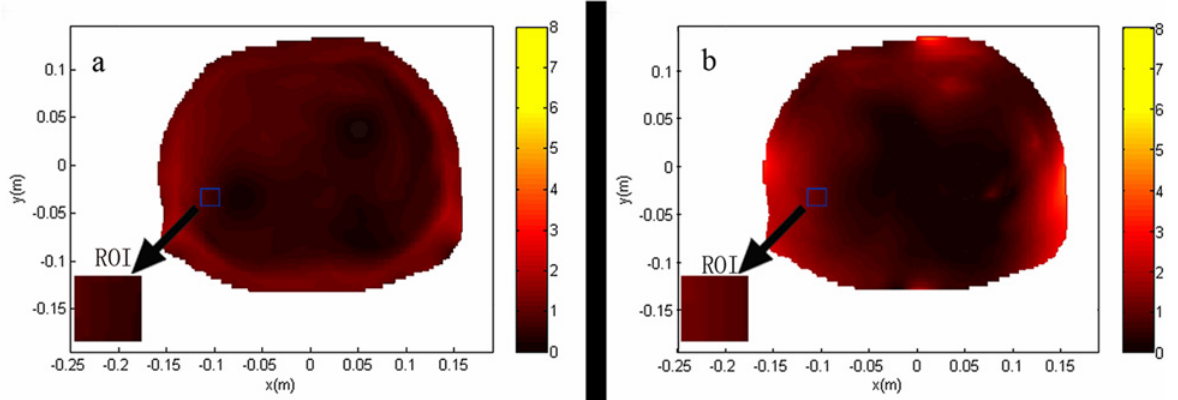
Fig 7. Theoretical B 1 field distribution through the transverse planes centered at the ROI used for the calculation of SNR of different coils. The value of SNR was obtained when the mean B 1 value within the ROI was 1.957 μ T. The SNR of body coil was normalized to 1 within the ROI for the transverse plane of body coil (a). The SNR of the transverse plane of phased array coil was 2.8387 (b). The results showed that the SNR of the phase array coil is higher than that of the body